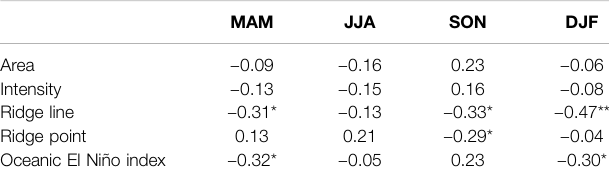
TABLE 2 | Correlation coef fi cients of the seasonal PRR in the MLRYR with the Northwest Paci fi c subtropical high index (area index, intensity index, ridge line index, ridge point index) and oceanic El Niño index.